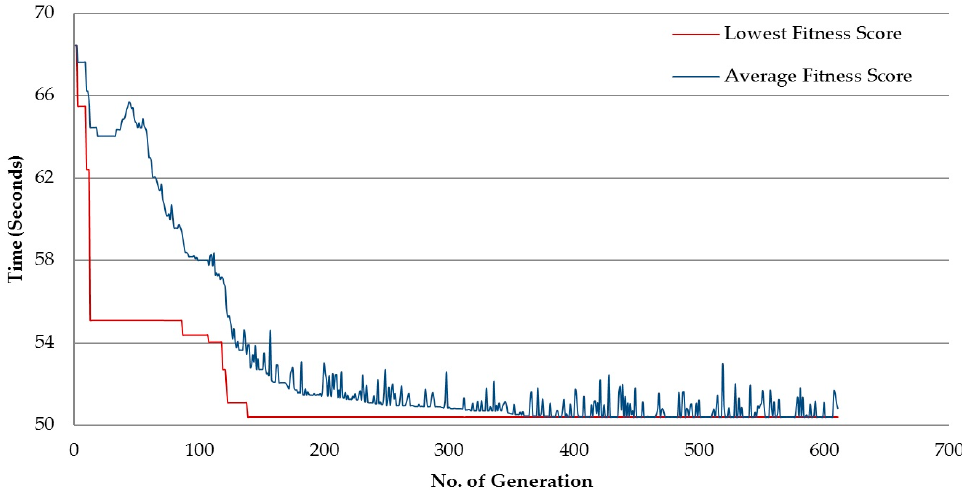
Figure 7. Performance graph of 20-node task flow (Minimise: (cid:1846) (cid:3047)(cid:3042)(cid:3047)(cid:3028)(cid:3039) ). Table 4. Performance comparison for 20-node task flow (Minimise: (cid:1846) (cid:3047)(cid:3042)(cid:3047)(cid:3028)(cid:3039) ). Result Parameters Genetic Algorithm Exhaustive Search All on Robot